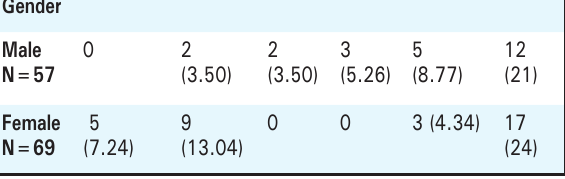
Table 6. Distribution of disorders according to gender, N (%). Affective Anxiety ADHD ODD